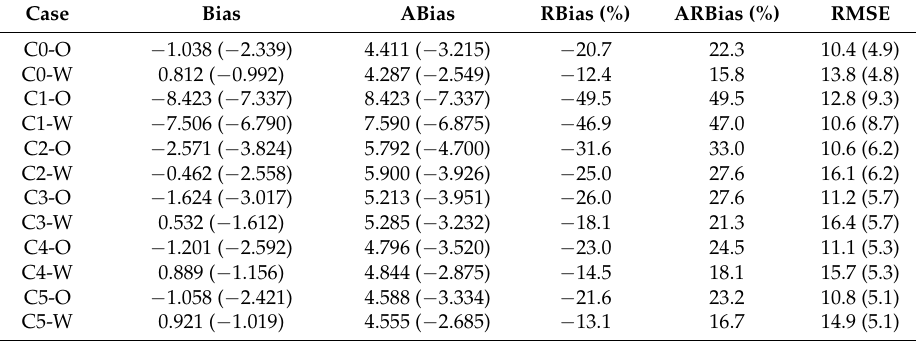
Figure 9. Boxplots of the bias, ABias, RBias (%), and ARBias (%) of wind potential energy estimates from the downscaled Weibull distribution with the OLS and WLS methods based on the wind potential energy from the observed Weibull distributions. Note that the wind potential energy of station #185 is not presented in bias and ABias. Because the magnitude of the wind potential energy for station #185 is approximately one hundred times the magnitude of the other stations, the boxplot does not properly represent the overall characteristics when the bias and ABias of station #185 are included. Table 5. Means of the evaluation criteria for the wind potential energy of the downscaled Weibull distributions based on the wind potential energy of the observed Weibull distributions of all the stations. Note that the biases of C3-W, C4-W, and C5-W are positive because the value of the wind potential energy for station #185 is a large positive number. Because the magnitude of the wind potential energy for station #185 is approximately one hundred times the magnitude of the other stations, the mean biases of these cases are shifted. The numbers in brackets indicate the means of the biases without station #185.